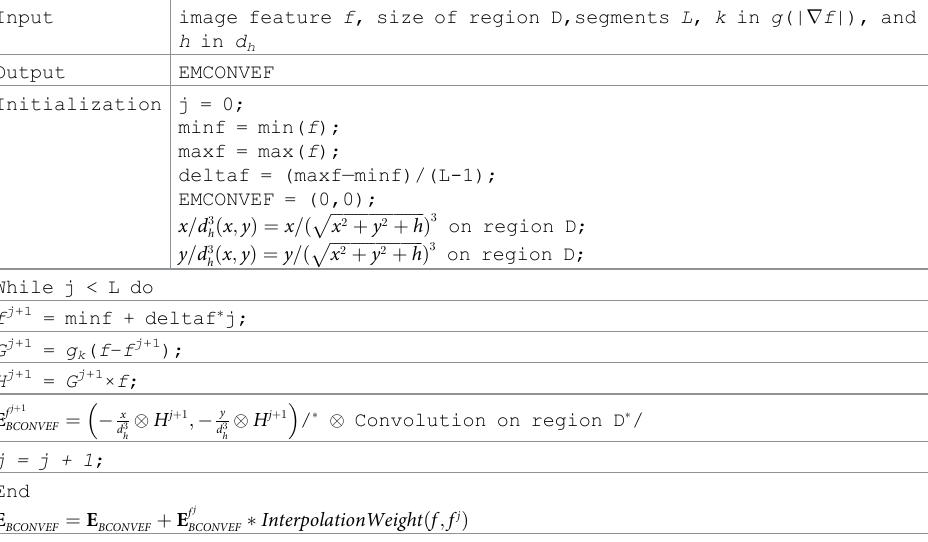
Algorithm 1. Implementation of the MCONVEF Model